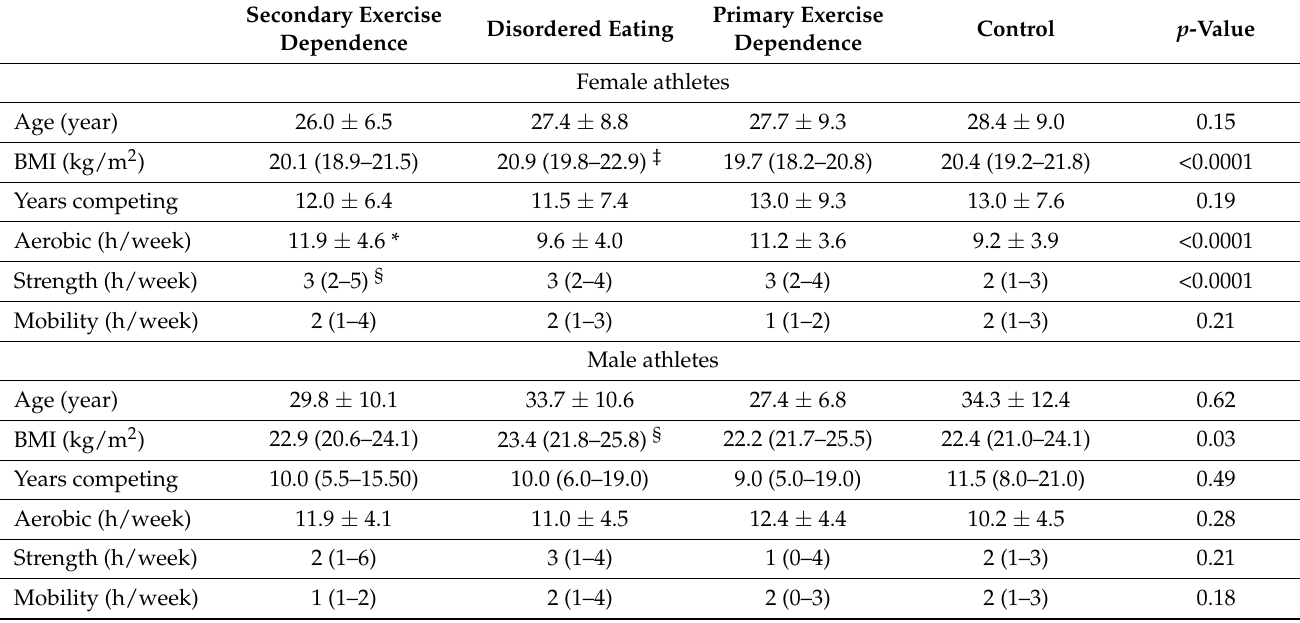
Table 2. Age, body mass index, and training information with disordered eating and exercise dependence